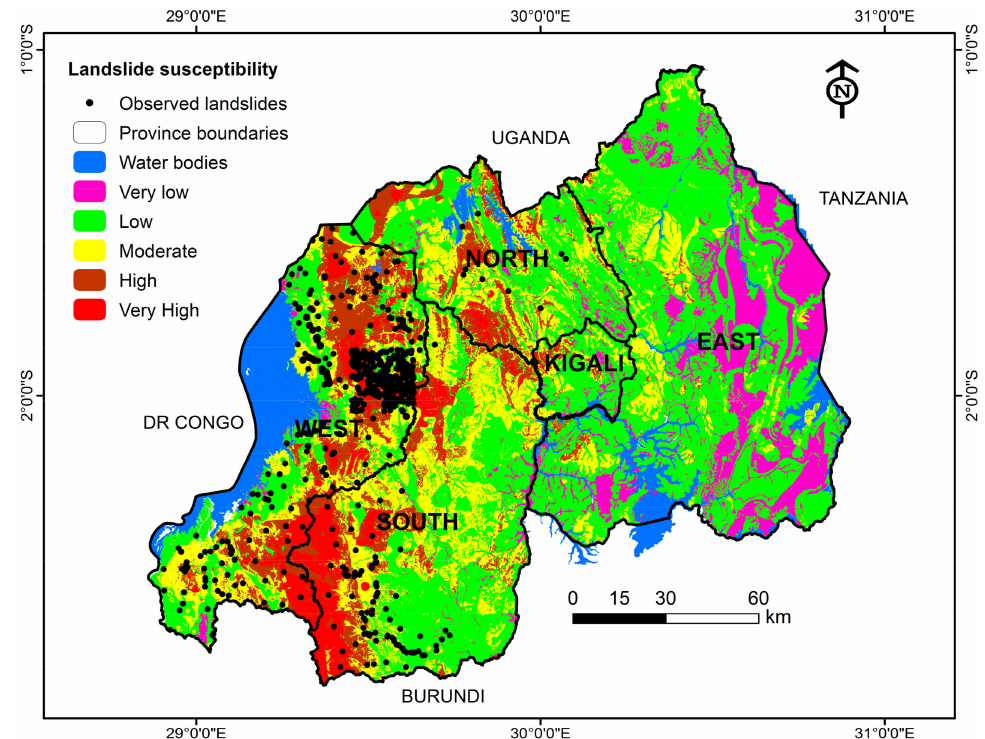
Figure 11. Landslide susceptibility map with past observed